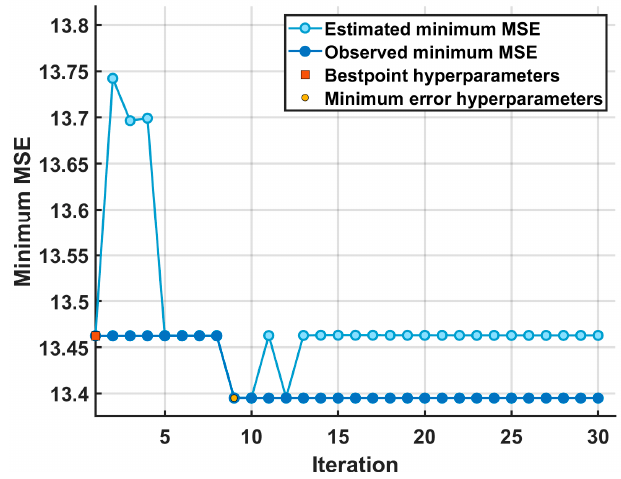
Figure 6. MSE optimization plot of the GPR model.